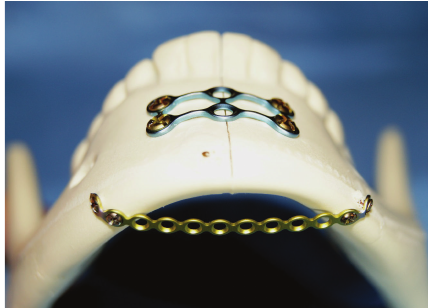
Figure 2: Two parallel plates (2PP).